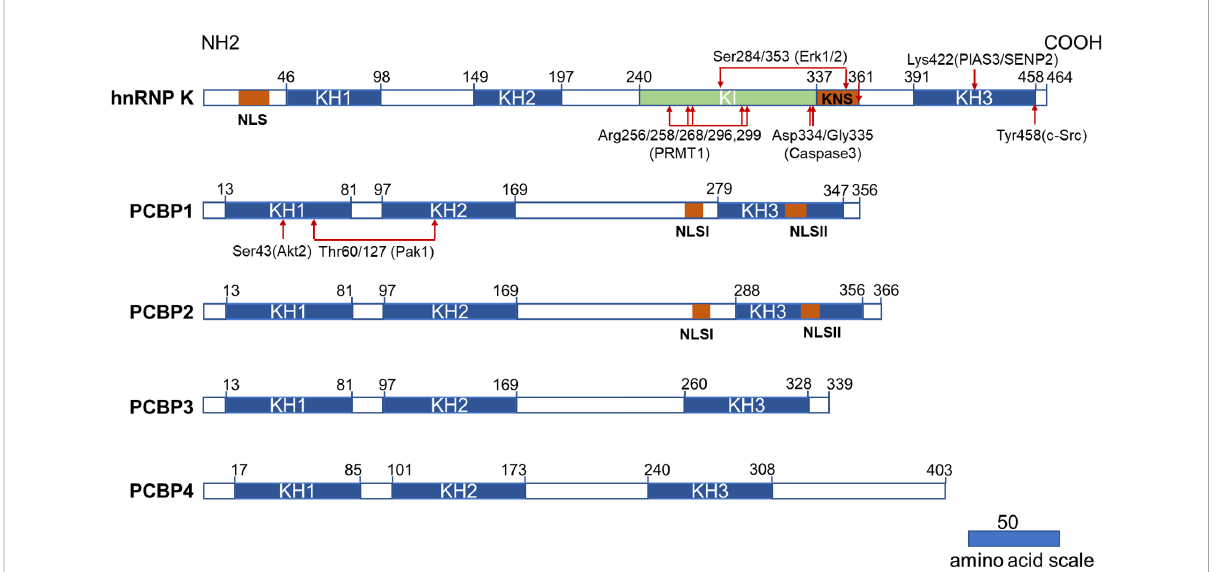
FIGURE 1 Structural characteristics of PCBPs and their post-translational modi fi cations related to the hematopoietic compartment. All PCBPs consist of triple KH domains. hnRNP K, PCBP1, and PCBP2 have two NLS sequences separately (NLS and KNS in hnRNP K while NLSI and NLSII in PCBP1 and PCBP2). hnRNP K has a unique KI domain responsible for interacting with various proteins. The post-translational modi fi cations and modifying enzymes related to the hematopoietic compartment are all revealed here. KH domain: hnRNP K homology domain; NLS: nuclear localization signal; KI: K-protein-interactive; KNS: hnRNP K nuclear shuttling; PRMT1: protein arginine methyl transferase 1; PIAS3: protein inhibitor of activated STAT3; SENP2: SUMO speci fi c peptidase